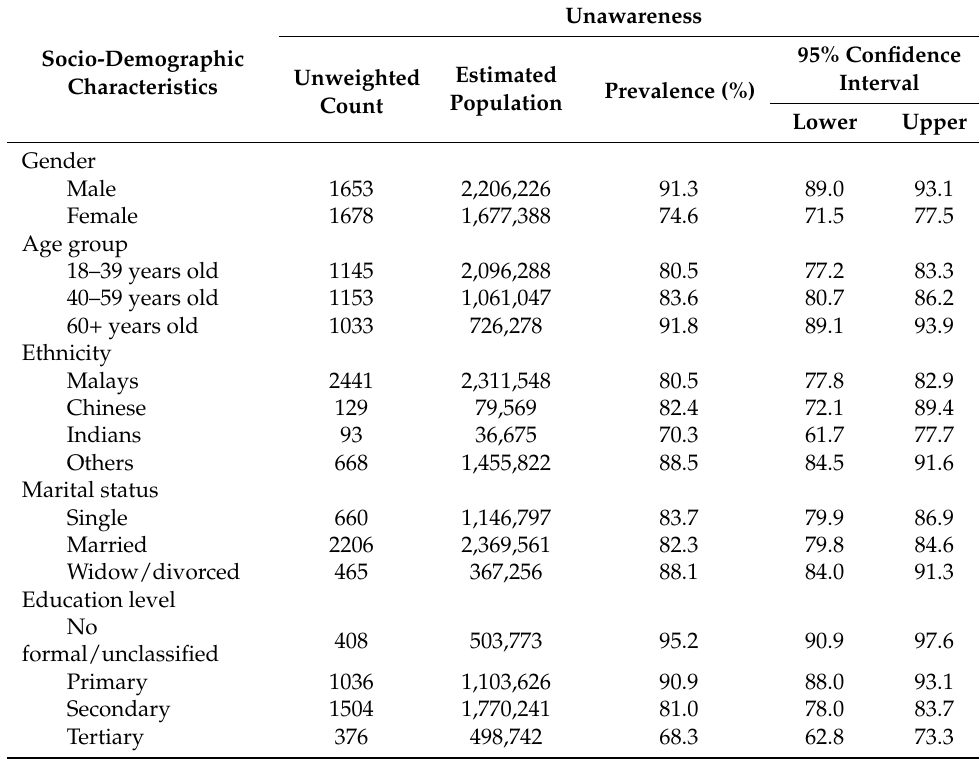
Table 1. Prevalence of Malaysian Healthy Plate concept unawareness according to socio-demographic